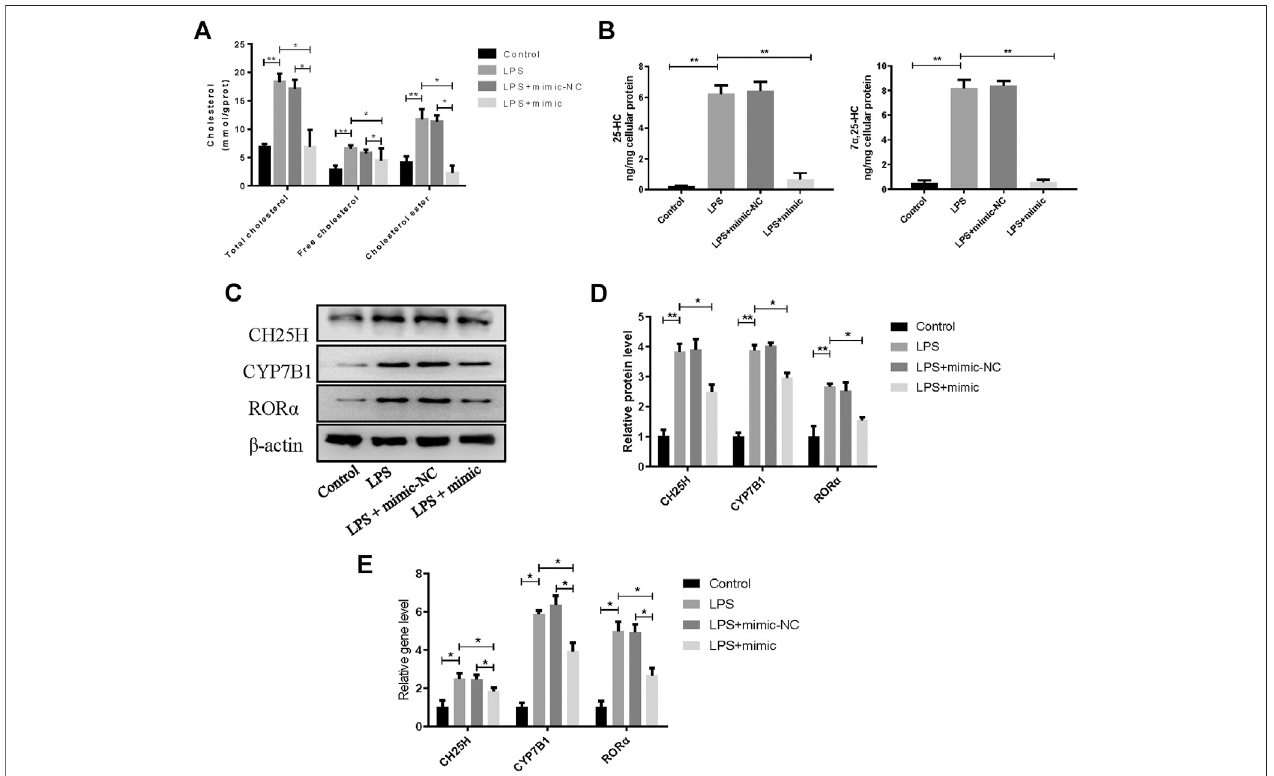
FIGURE 4 | MiR-10a-3p participates in cholesterol metabolism disorders via CH25H/CYP7B1/ROR α axis in chondrocytes. (A) Total cholesterol, free cholesterol and cholesterol ester were detected in chondrocytes. (B) 25-HC and 7 α , 25-HC were detected in different group of chondrocytes. (C) CH25H, CYP7B1, and ROR α expression in chondrocytes were analyzed via western blotting. The band intensity was quanti fi ed by normalizing to β -actin ( n (cid:1) 3). (E) CH25H, CYP7B1, and ROR α expression in chondrocytes were analyzed via qRT-PCR. Quantitative data were presented as mean ± SD. * p < 0.05, ** P < 0.01.